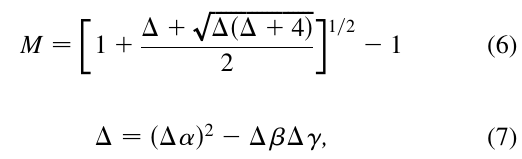
FIG. 19. (Color) Mean value of horizontal and vertical 95% rms emittance at the end of the DTL as a function of the transverse zero current phase advance (cid:4) o